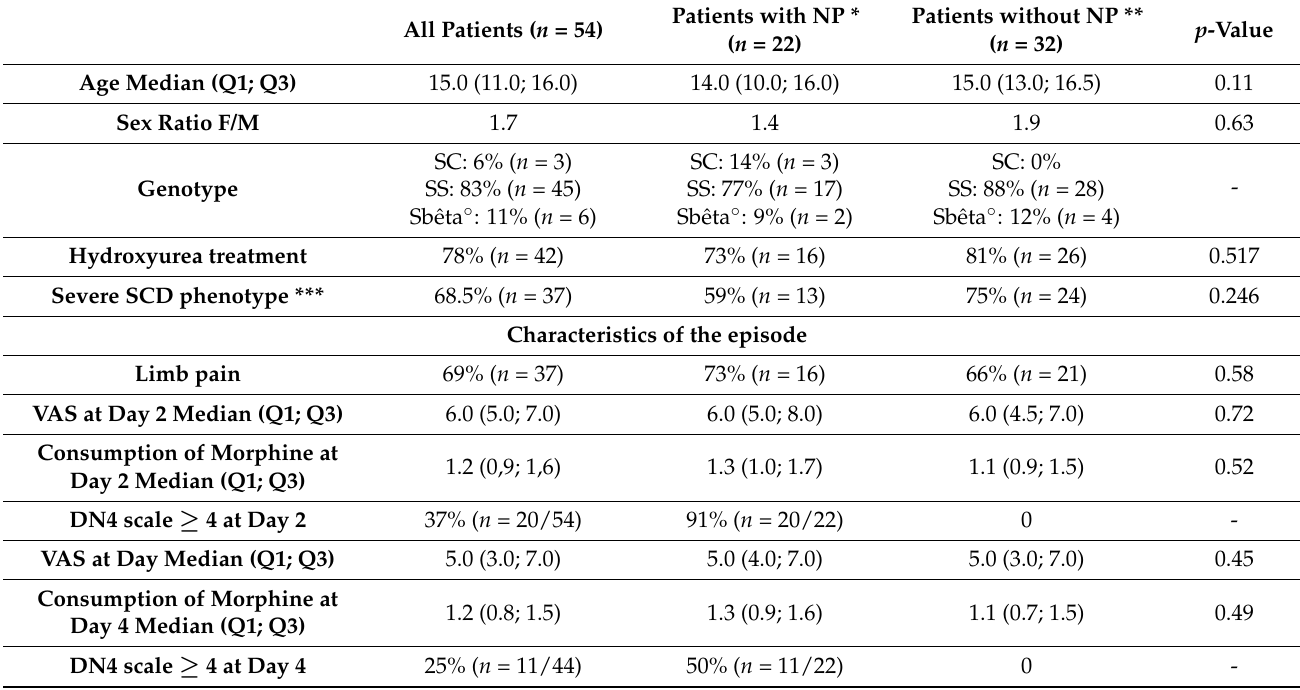
Table 1. Demographic data and description of the vaso-occlusive crises (Visual Analog Scale (VAS), Consumption of morphine, and DN4 scale